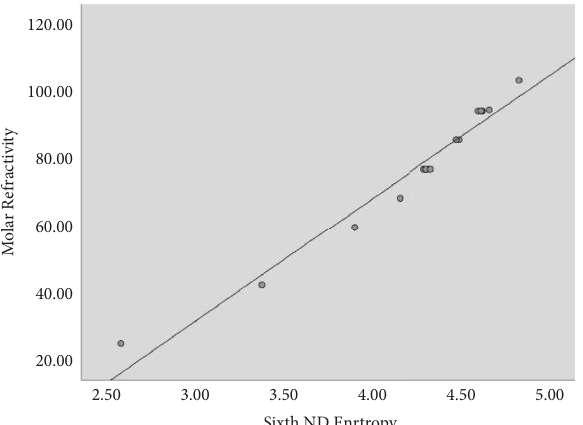
Figure 10: Graphical representation of LRM between molar refractivity and the sixth ND Table 10: The significant LRM: Henry’s law of benzene derivatives on indices. Entropies